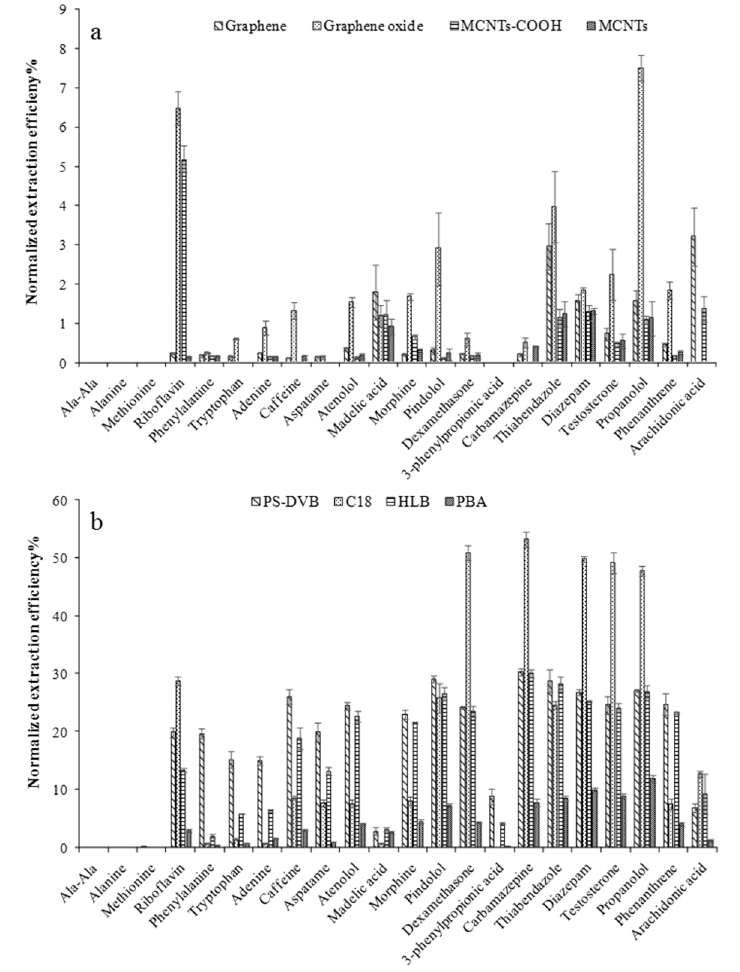
Figure 2. Comparison of extraction performances of the eight coatings for all analytes at pH 7.4, ( a ) carbon-based coatings, ( b ) solid phase extraction (SPE)-based coatings. Extractions were performed in triplicate for 2 h, and desorption was performed for 1 h using desorption solvent 2.